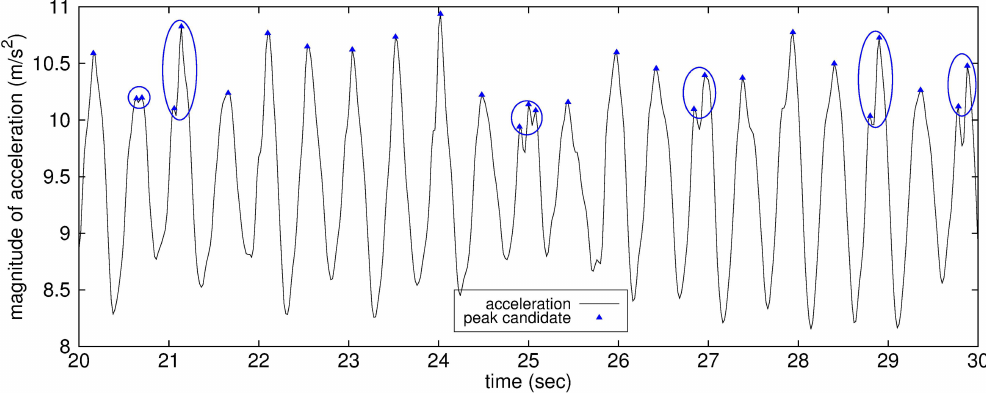
Figure 4. Group of peak candidates gathered in a very short time